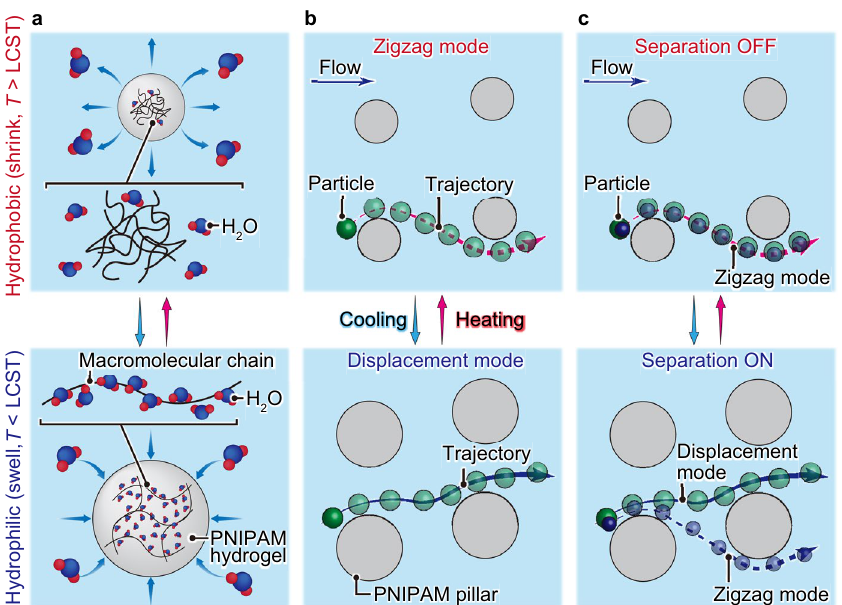
Figure 1. Thermally-tunable deterministic lateral displacement (DLD) of particles flowing through micropillar arrays made of poly( N -isopropylacrylamide) (PNIPAM) hydrogel. ( a ) Schematic illustration showing the volume phase transition of PNIPAM hydrogel across lower critical solution temperature (LCST). ( b,c ) Schematic illustration explaining the two experiments demonstrated in this study. ( b ) Thermo-responsive switching of the particle trajectories between the displacement and zigzag modes. ( c ) Thermo-responsive on–off operation in the DLD separation of the two particle populations of different